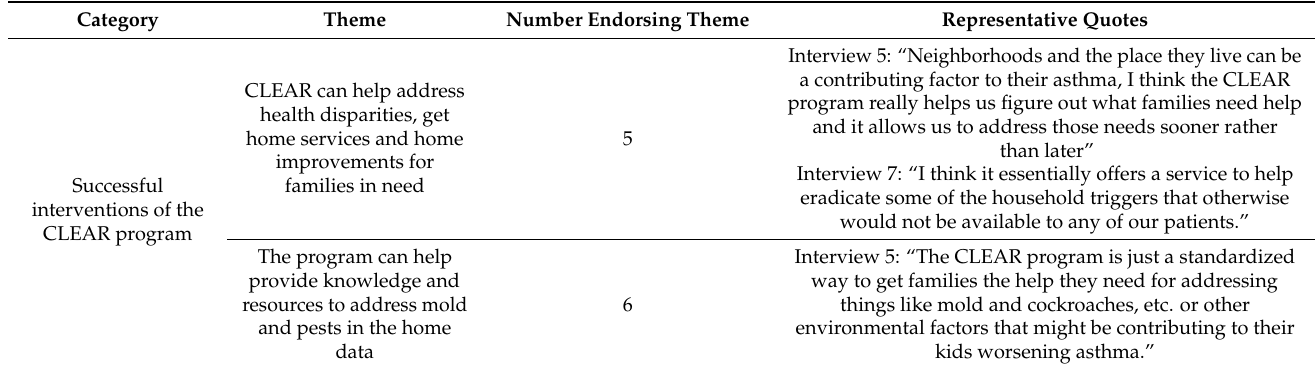
Table 2. Health professionals’ perceptions of successful interventions of the CLEAR